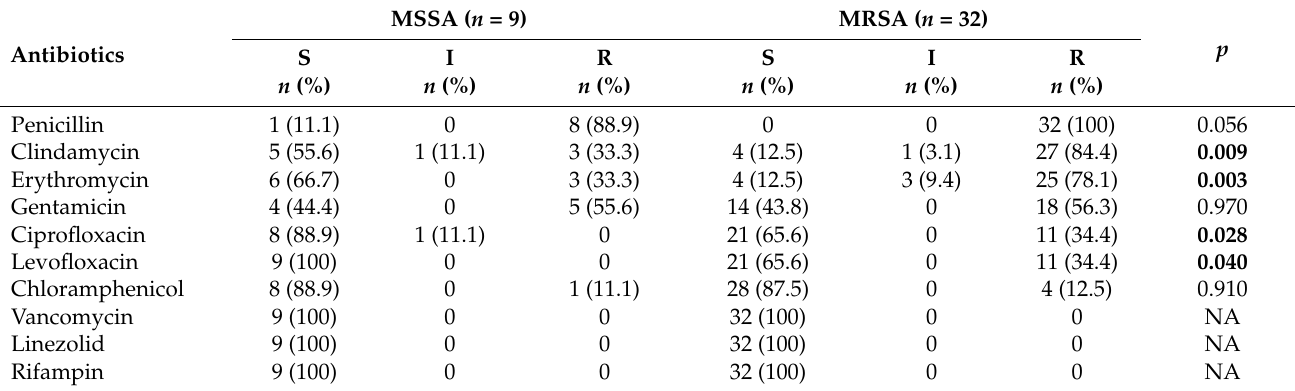
Table 2. The susceptibility to antibiotics of MSSA ( n = 9) and MRSA ( n = 32).